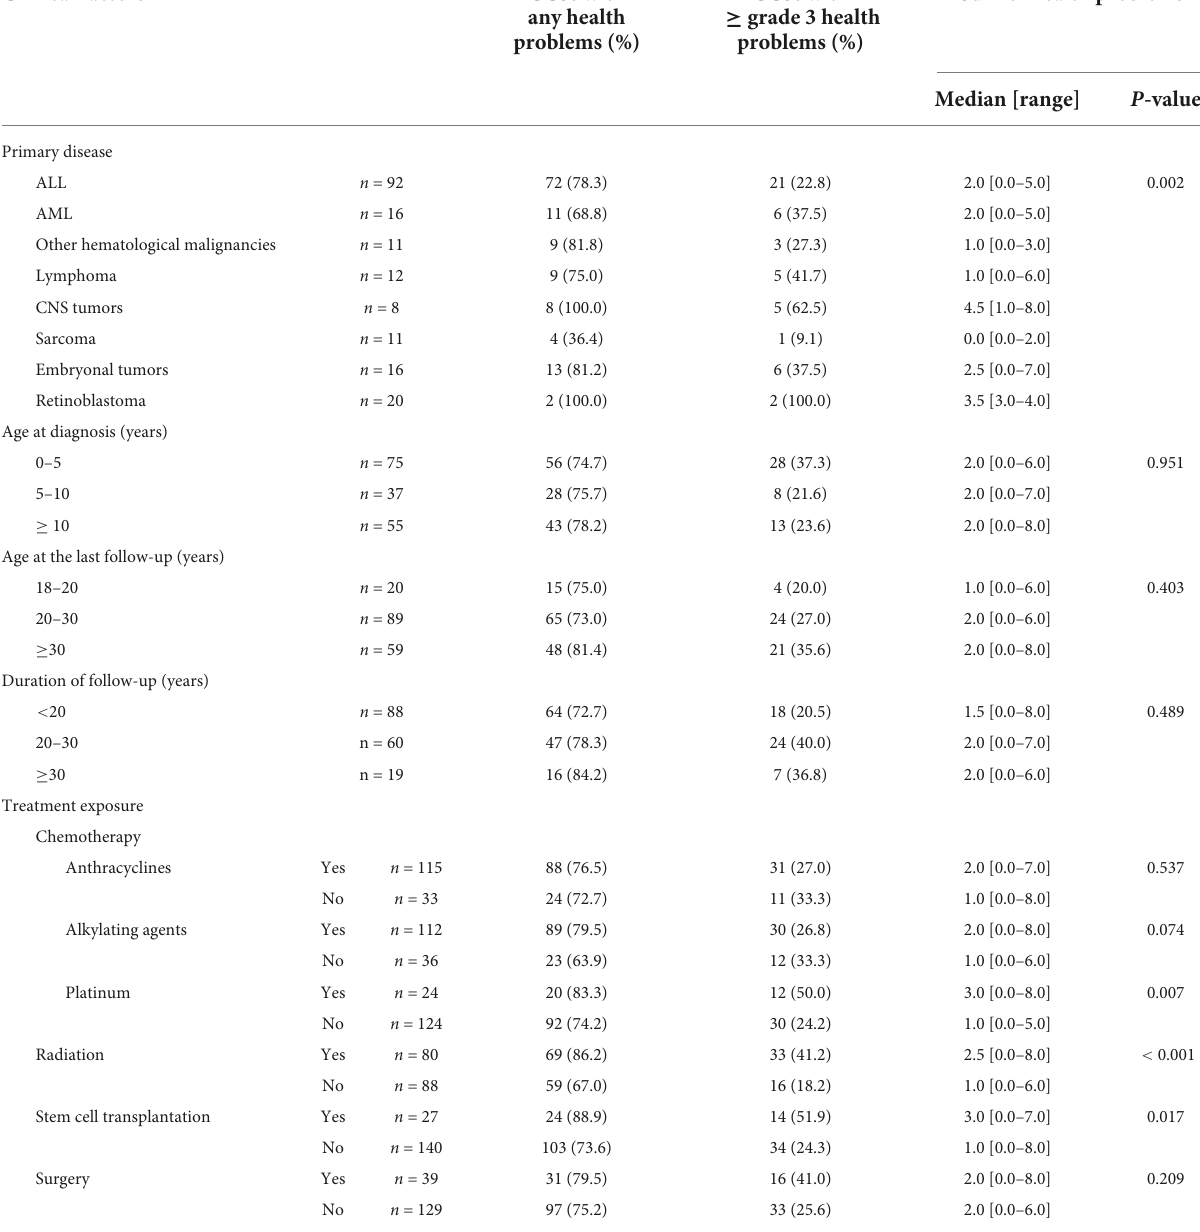
TABLE 5 Health problems by clinical